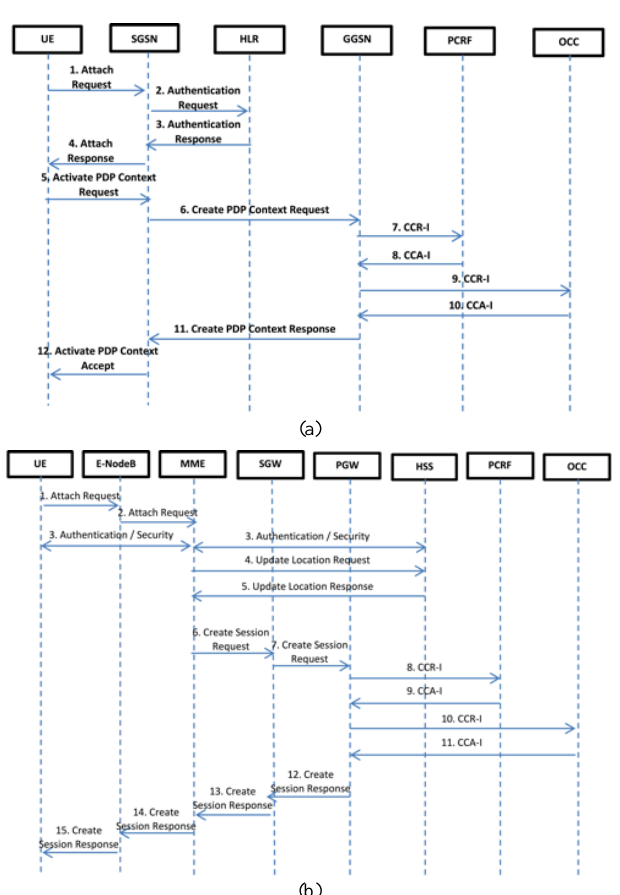
Fig. 3. Data Call Setup Flow: (a) 2G/3G; (b) 4G